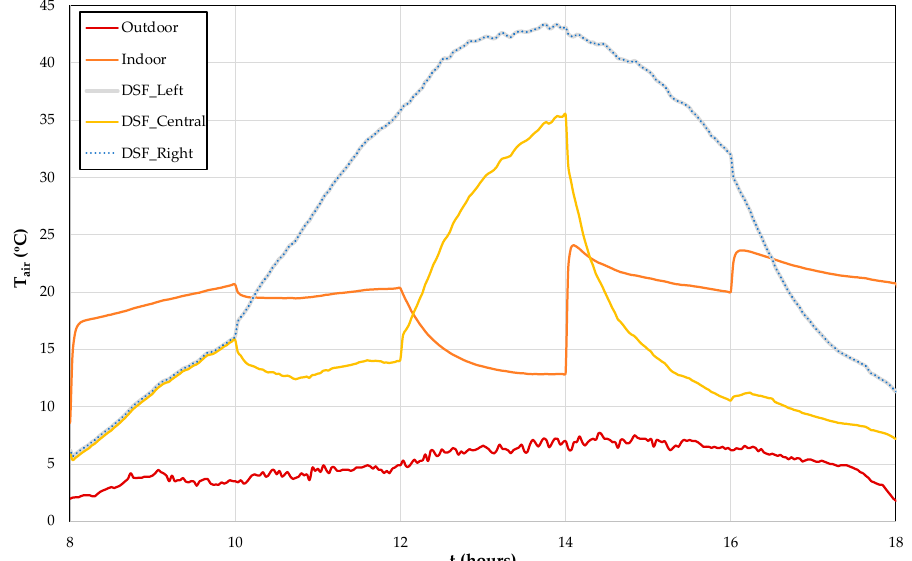
Figure 20. Evaluation of air temperature (T air ) of the outdoor environment, indoor virtual chamber and indoor left, central and right DSF system, when the airflow rate is variable and the number of DSFs to operate is variable, for the Case H.